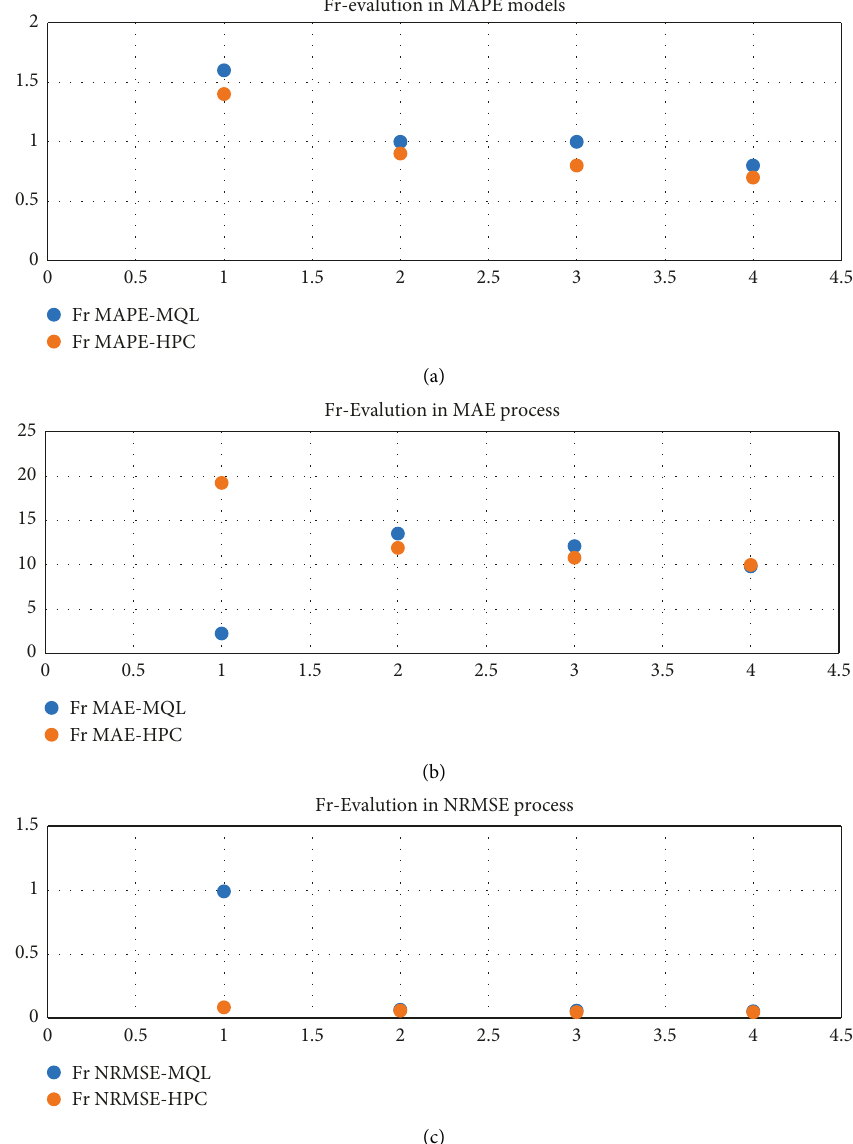
Figure 4: (a–c) Machine learning performance for reducing machining force. (a) Fr-evaluation in MAPE models. (b) Fr-evaluation in MAE process. (c) Fr-evaluation in NRMSE